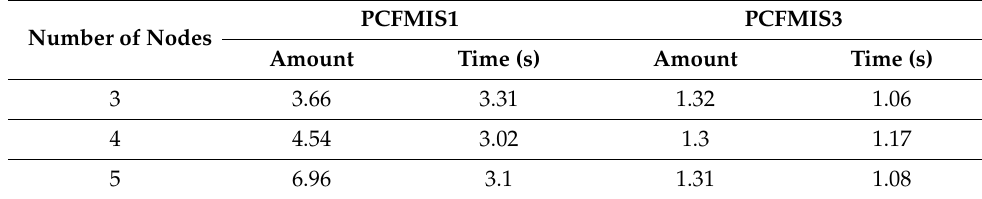
Table 2. The amount ratio and time ratio in different Gnum groups of CSLOGS10.